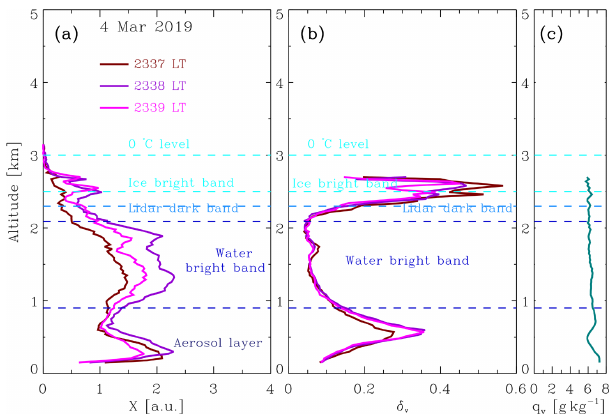
Figure 10. Three 1min lidar X and δ v profiles covering the period from 23:37 to 23:39LT on 4 March 2019 and a 1h averaged lidar q v profile centered at 23:38LT on the same day, exhibiting the vertical structure of the X and δ v precipitation streaks as well as the water vapor mixing ratio when the surface precipitation rate was highest (3.2mmh − 1 ) during the studied moderate warm-front precipitation event (yielding thick liquid-water accumulation on the roof win- dows of the lidars; see photo V in Fig.